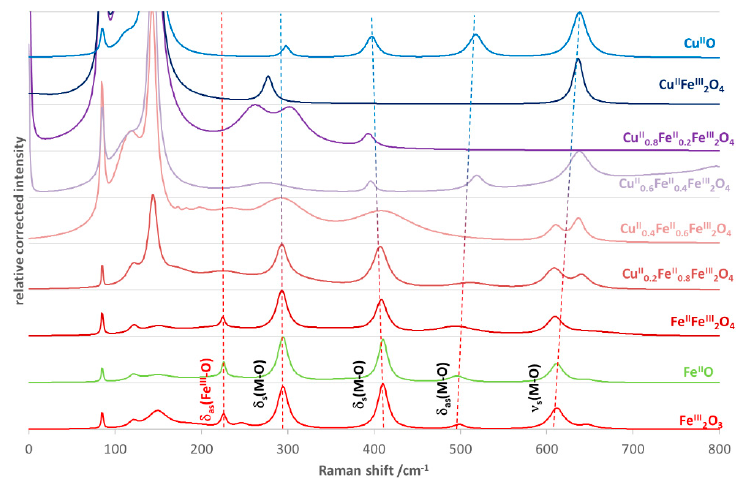
Figure 3. Raman spectra of iron(II) doped copper ferrites compared to those of the simple oxides of the given metal ions.